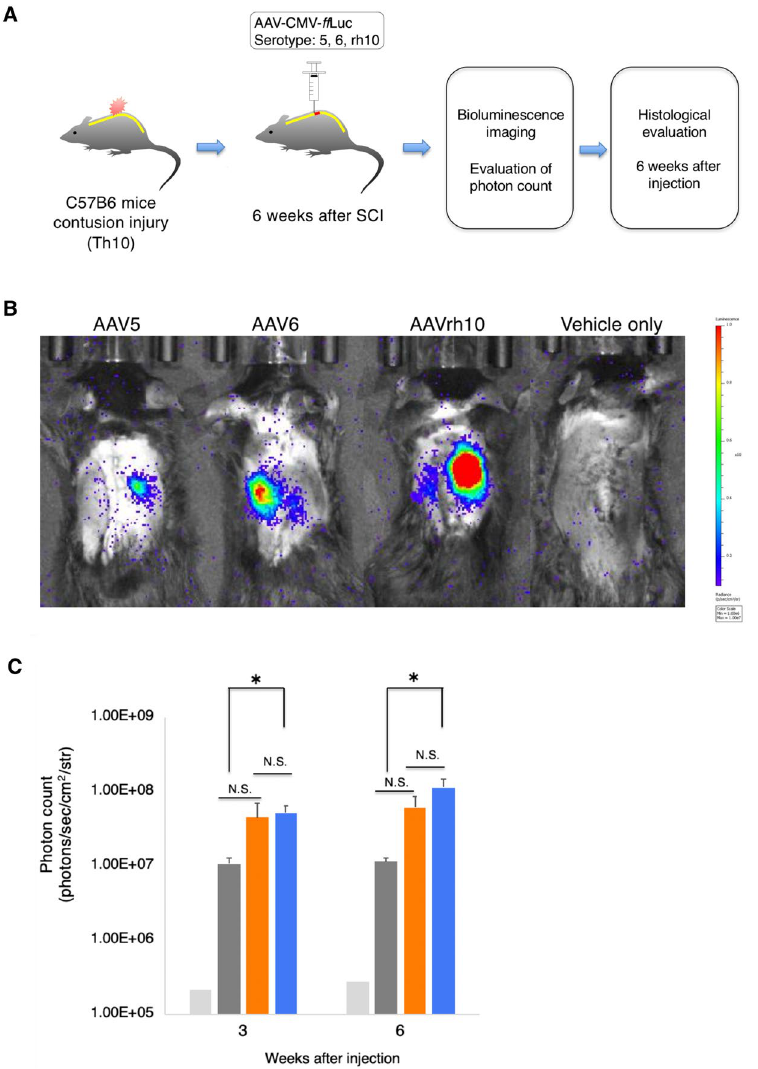
Figure 3. Chronically injured spinal cord was effectively transduced by AAVrh10. ( A ) Schematic diagram of AAV- ff Luc injections into the chronically injured mouse spinal cord. AAV serotypes 5, 6, and rh10 were injected into the chronically injured spinal cord. Mice injected with vehicle only were used as negative controls. ( B ) Representative in vivo BLI of a mouse at 6 weeks post injection of AAV- ff Luc. ( C ) Photon counts from in vivo BLI derived from AAV- ff Luc until 6 weeks post injection. AAVrh10 exhibited a higher photon count than AAV5 at 6 weeks after injection. * p < 0.05 and not significant (N.S.) according to one-way ANOVA with the Tukey- Kramer test. Data are presented as the mean ± SEM. n = 4 for each